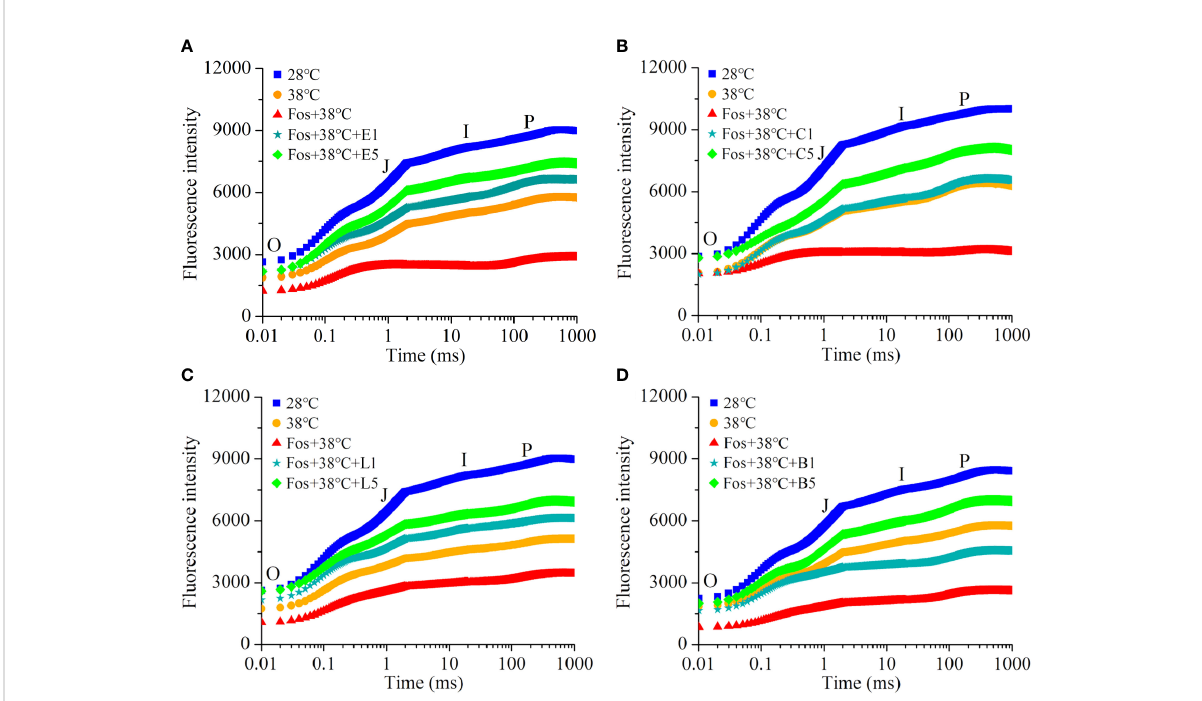
FIGURE 4 Effects of the uppermost monoterpenes on chlorophyll fl uorescence kinetics in C . camphora . (A) Eucalyptol chemotype (EuL); (B) Camphor chemotype (CmR); (C) Linalool chemotype (LnL); (D) Borneol chemotype (BeL). 28°C, 38°C, and Fos+38°C: C . camphora was treated with normal temperature, high temperature, and high temperature with fosmidomycin (Fos) pretreatment, respectively. Fos+38°C+E1 and Fos+38°C +E5: EuL blocked monoterpene synthesis with Fos was fumigated with 1 and 5 m M eucalyptol at 38°C, respectively. Fos+38°C+C1 and Fos+38° C+C5: CmR blocked monoterpene synthesis with Fos was fumigated with 1 and 5 m M camphor at 38°C, respectively. Fos+38°C+L1 and Fos+38° C+L5: LnL blocked monoterpene synthesis with Fos was fumigated with 1 and 5 m M linalool at 38°C, respectively. Fos+38°C+B1 and Fos+38°C +B5: BeL blocked monoterpene synthesis with Fos was fumigated with 1 and 5 m M borneol at 38°C, respectively. Means (n = 4) are